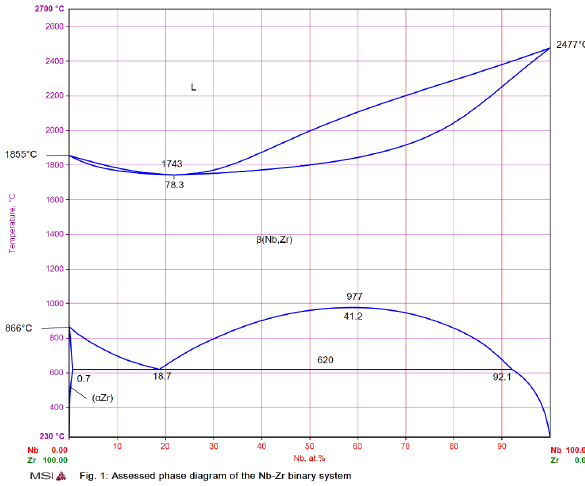
Figure 1: Binary phase diagram of Zr-Nb alloy (at.%)